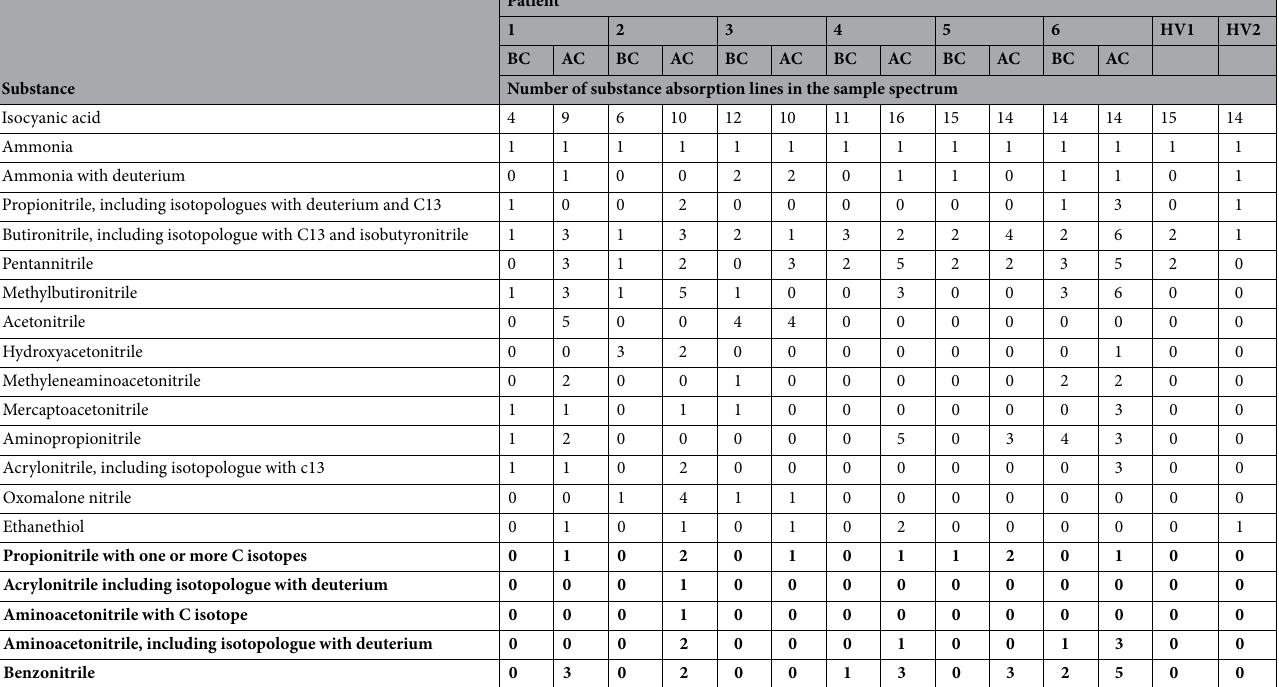
Table 1. Vapor composition of the urine, taken from healthy volunteers (HV1, HV2) and cancer patients before (BC) and after chemotherapy (AC). The candidates for markers of subtle renal damage are marked in